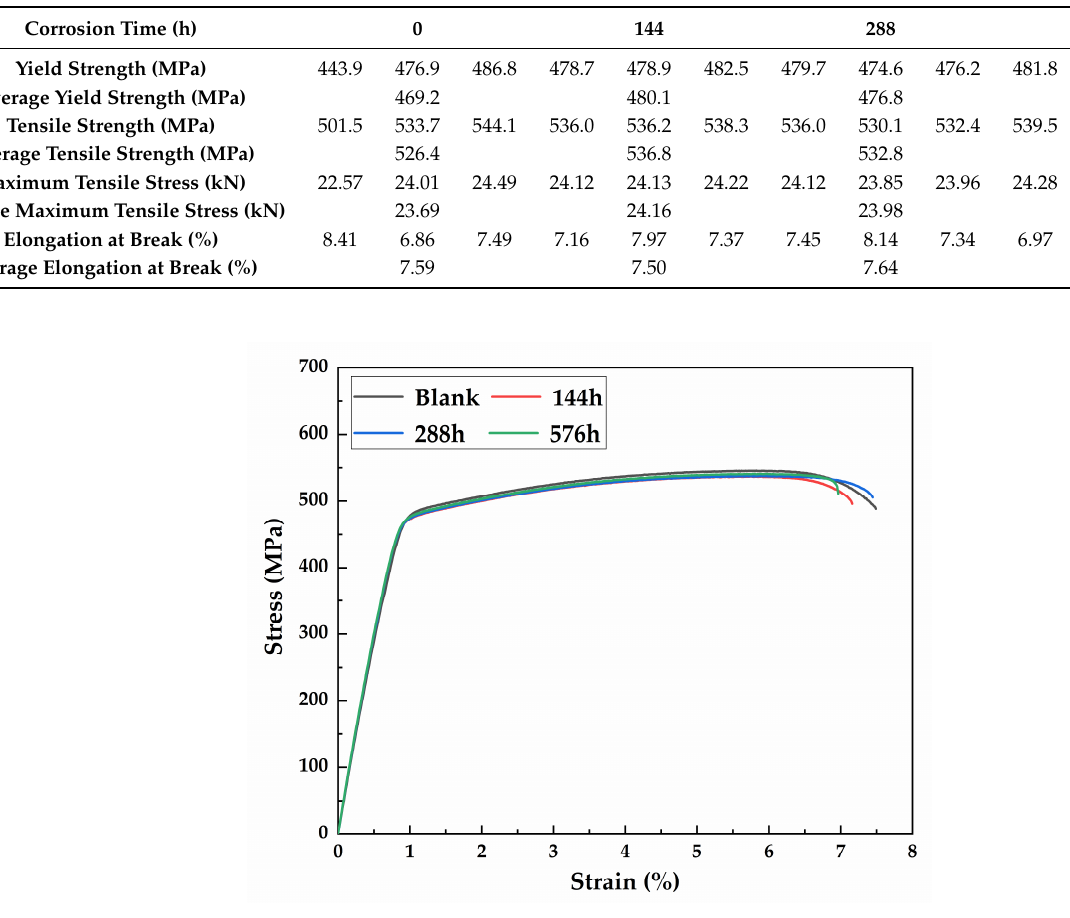
Figure 5. Stress–strain curve of the 7B04-T74 aluminum alloy after alternate immersion test.